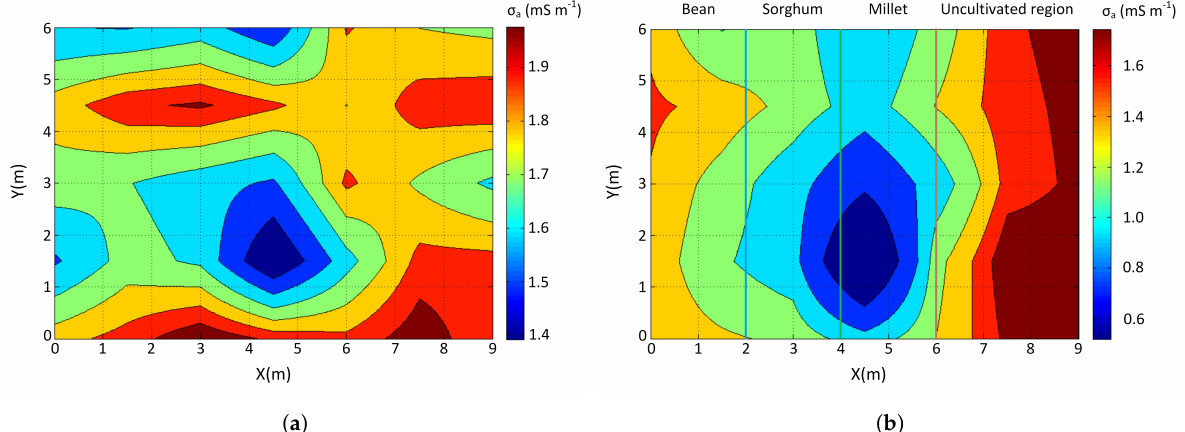
Figure 17. Spatial distribution of σ a in the delimited area of 54 m 2 : ( a ) before sowing crops and ( b ) 62 days after sowing the